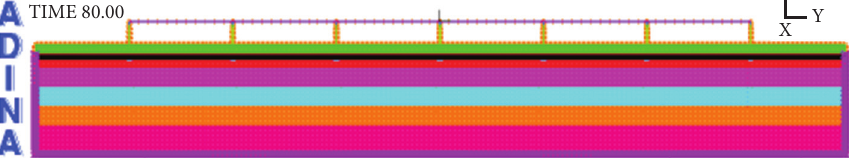
Figure 4: Numerical model.